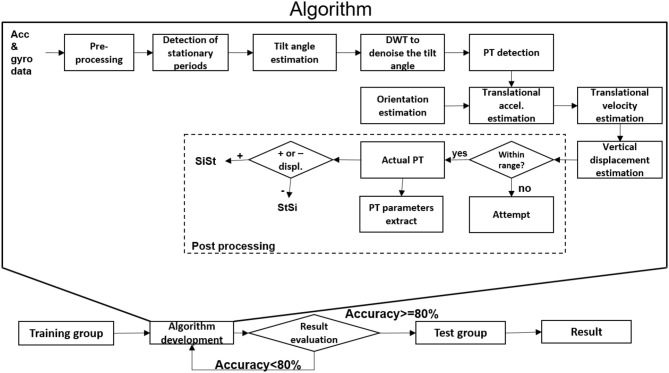
Algorithm development and validation steps for postural transition (PT) detection. Acc, accelerometer; accel, acceleration; DWT, discrete wavelet transform; gyr, gyroscope; SiSt: sit-to-stand, StSi: stand-to-sit; +/-, positive/negative.